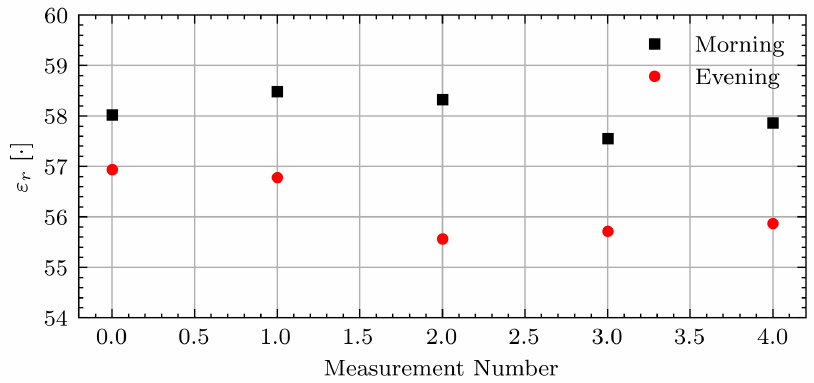
Figure 11. Estimated permittivity for Volunteer B on fasting day